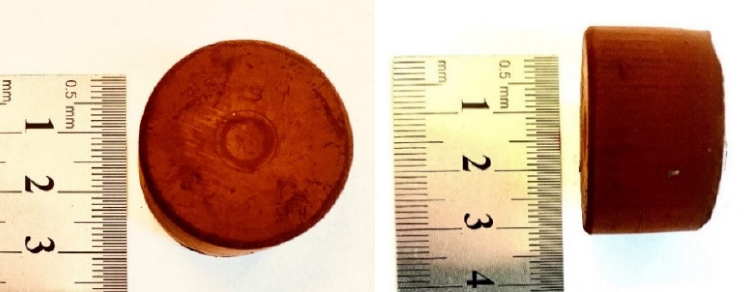
Figure 3. The dry 2-thiazolecarboxaldehyde-based monolithic organic gel (organic xerogel).